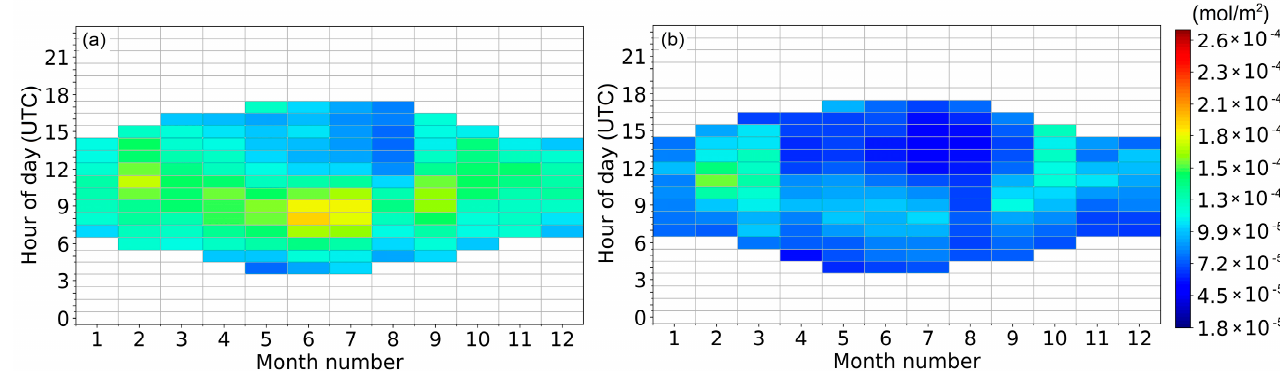
Figure 7. Hourly and monthly variation of in situ NO 2 for ( a ) weekdays and ( b ) weekends over the period 2017–2022. The most relevant feature is the seasonal variation of the NO 2 peak value correlated to the Sun illumination over the year. In fact, both during weekdays and weekends, the VC (Figure 4) and TC (Figure 5) peaks are observed at about 13:00 UTC between November and January, and at about 8:00 UTC for June and July. For SC (Figure 6), the peaks follow the same seasonal trend, but the highest values occur approximately three hours before that of columnar contents due to the proximity of the emission sources. In fact, since the near-surface and the in situ concentration of NO 2 are closely linked to local emissions, in the urban area of Rome a morning peak between 07:00 and 09:00 UTC and a second peak between 20:00 and 22:00 UTC, higher than the morning one, are expected [51]. Anyway, Pandora measurements stop just before sunset: during summer, they are limited to about 18:00 UTC while, in the winter months, due to the shorter duration of daytime hours, the measurements typically end at 15:00 UTC, not catching the afternoon peak. Nonetheless, a slight increase in SC-NO 2 in the evening hours during the warm months is still noticeable on both weekdays and weekends. The double daily peak is clearly observable from in situ concentrations (Figure 7) provided by the Villa Ada station, which operates routinely, carrying out measurements throughout the day. The observed diurnal and seasonal variations agree with [48], who observed two diurnal peaks for the NO 2 surface concentration at 07:00 UTC and 18:00 UTC, more evident during wintertime, associated with atmospheric dynamics and peaks in vehicular traffic. In fact, as reported by [53], the double peak daily cycle of NO 2 is observable in the NO 2 concentrations, but not in its vertical fluxes. It suggests that the amount of atmospheric NO 2 is mainly driven by the dynamics of the atmospheric boundary layer,